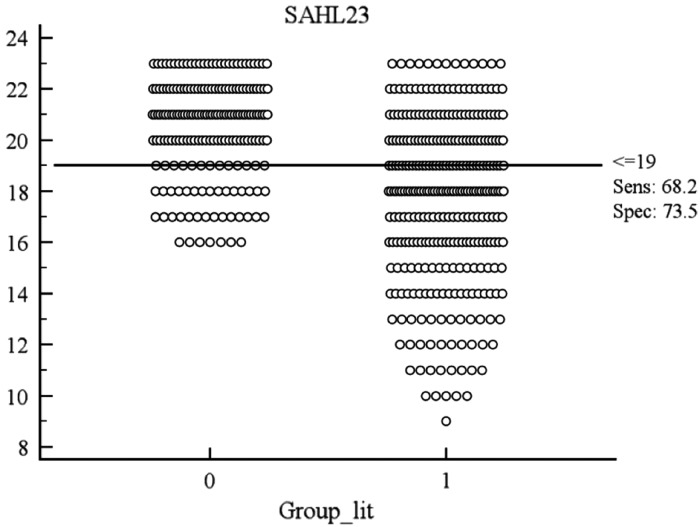
Interactive dot diagram with sensitivity and specificity plotted against the criterion value (n=484). SAHL=Short Assessment of Health Literacy.